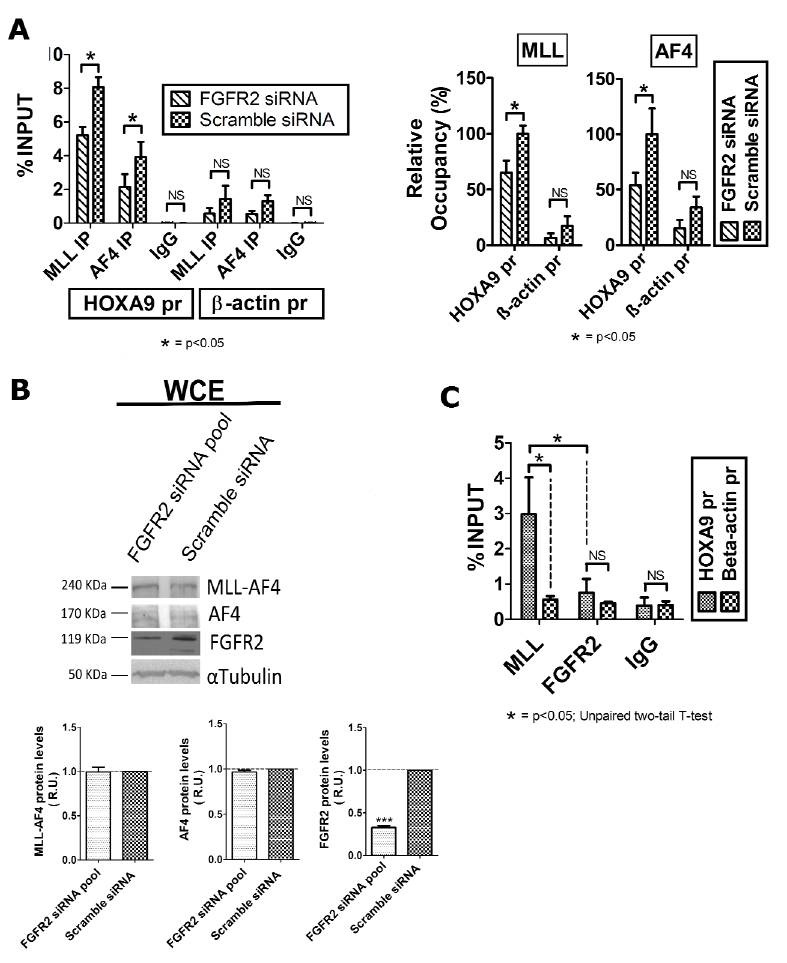
Figure 3. FGFR2 contributes to the interaction of AF4 and MLL-AF4 at the HOXA9 promoter (HOXA9 pr), in RS4;11 leukemia cells. ( A ) ChIP assays performed to test the binding of AF4 and MLL-AF4 to HOXA9 pr, after FGFR2 silencing. Scramble siRNA represents the negative control. ( B ) Western blot analysis of total protein (WCE) extracted 72 h after transfection of a FGFR2-siRNA pool carried out to reveal expression level of endogenous MLL-AF4, AF4, and FGFR2; scramble siRNA represents the negative control; α -tubulin was used to normalize protein loading. ( C ) Interaction of endogenous MLL and FGFR2 with the HOXA9 pr. ChIP data are expressed as percentage of HOXA9pr and β -actin promoter ( -actin pr) in precipitated chromatin compared with the INPUT; IgG mix is the negative control. Results represent the average of three independent experiments. Error bars indicate the standard deviations. Statistical significance is calculated by one-way two tail paired t -test. p -values are indicated as follows: * = p < 0.05, *** p = < 0.005. NS, not significant. R.U., relative units.